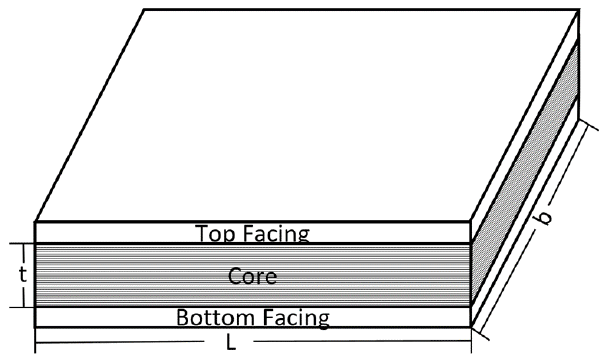
Figure 1. General sandwich panel